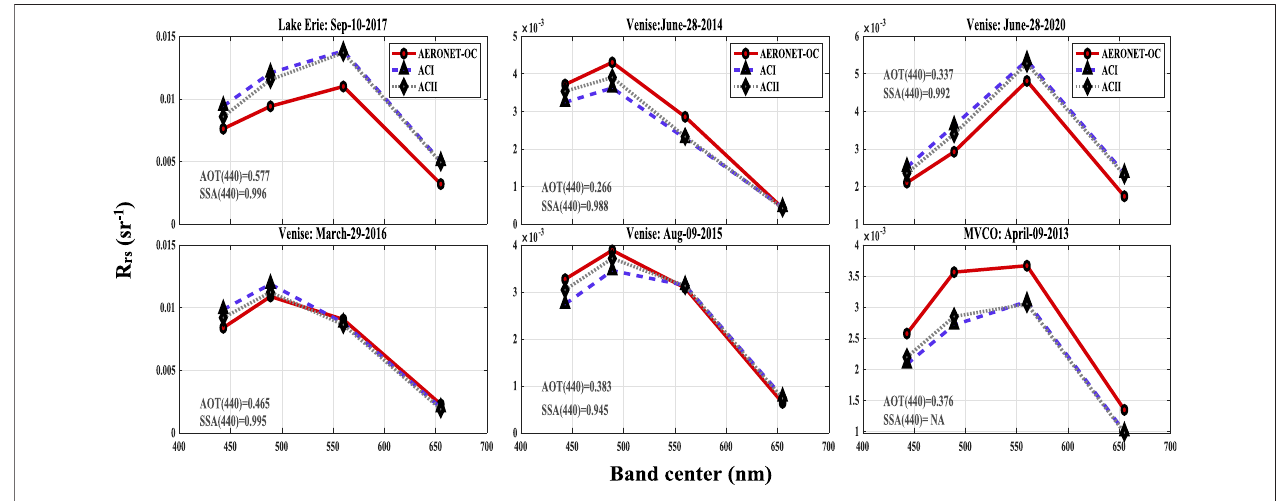
FIGURE 8 | OLI-retrieved R rs shown for selected matchups. The spectra recovered through ACII (dotted) are more consistent with in situ (solid) than those estimated via ACI (dashed). The reported AOD(440) and SSA(440) (Level 1.5 and 2.0) are annotated for each instance. Note the differences in the ranges of y -axes.